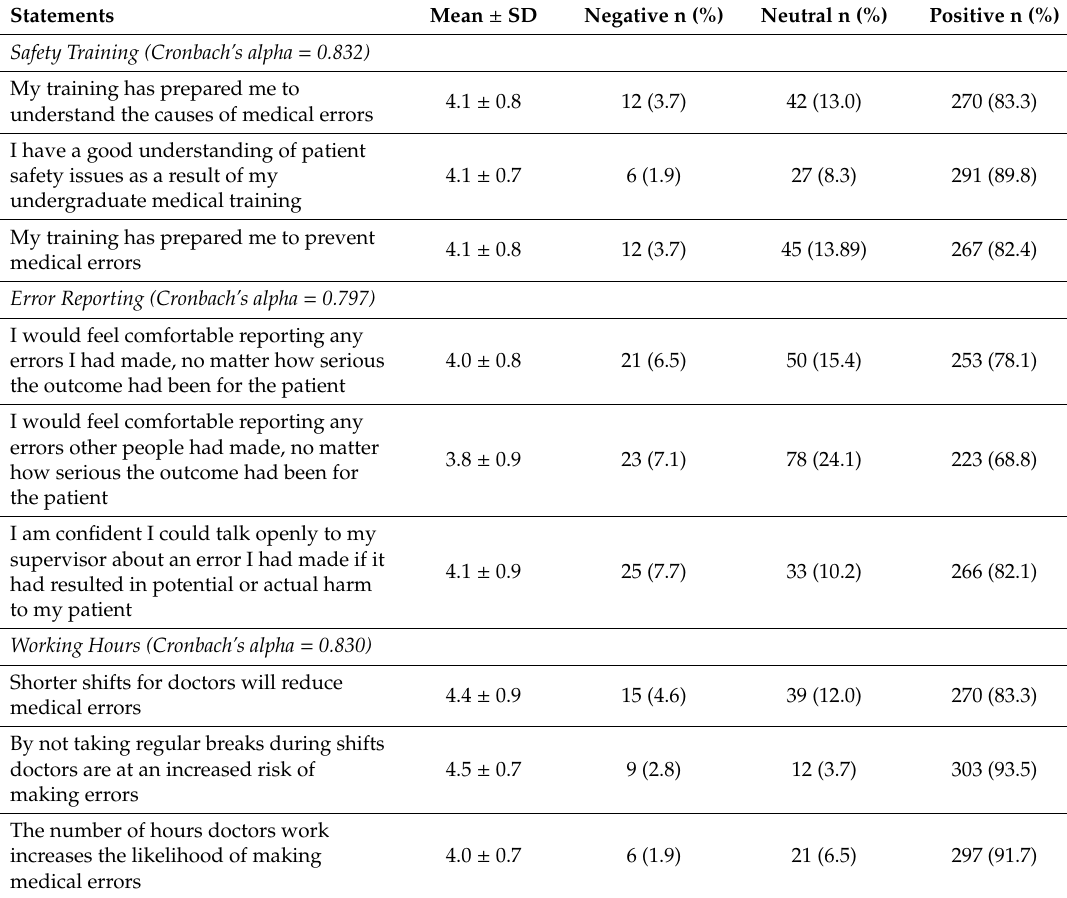
Table 2. Responses to the safety attitude statements in the Attitudes Toward Patient Safety Questionnaire